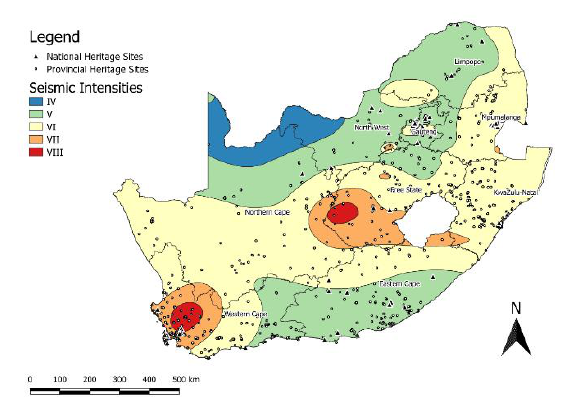
Figure 4: Map showing National and Provincial Heritage Sites in relation to identified seismic intensity risk areas (SAHRA, 2019) From this analysis we can determine that 60% of all NHS’s fall within regions of strong to severe (VI-VIII) regions of seismic intensity. 70% of PHS’s are found within areas of strong to severe intensity (SAHRA, 2019).